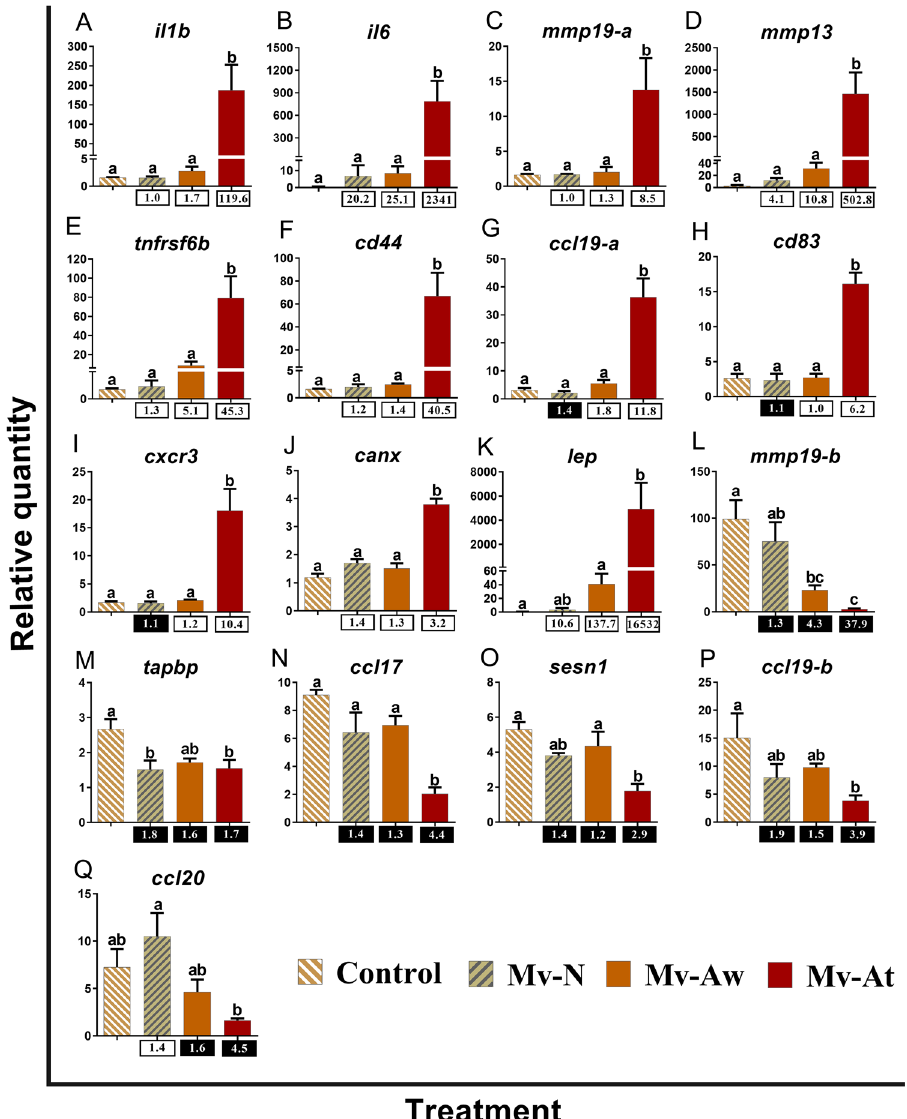
Figure 5. qPCR for M. viscosa -responsive transcripts playing putative roles in adaptive immune responses. The skin samples of M. viscosa -infected Atlantic salmon at the lesion (Mv-At; n = 4) and away (Mv-Aw; n = 4) sites, as well as the samples of fish with no lesion in M. viscosa group (Mv-N; n = 3) and non-infected control group (Control; n = 4), were used for qPCR validation. Data are presented as mean ± SE, with the lowest expressing sample as calibrator [i.e. set to relative quantity (RQ) 1.0]. Letters in each panel indicate significant differences between groups, as determined by one-way ANOVA with Tukey’s post hoc test ( p < 0.05). Fold-changes are shown below the groups, calculated as mean RQ of the group/mean RQ of the control. Black boxes indicate the down-regulated or negative fold-changes, which were calculated as 1/fold-change for comparisons that yielded fold-change values less than 1. Gene symbols are shown at the top of each panel ( A – Q